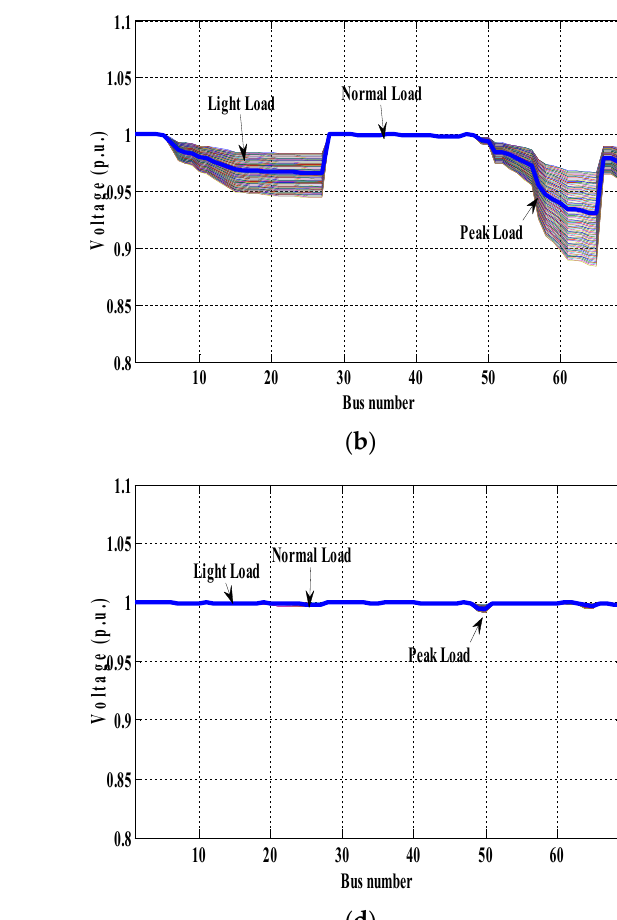
Figure 11. Comparison of active power loss for various scenarios (IEEE 69-Bus).